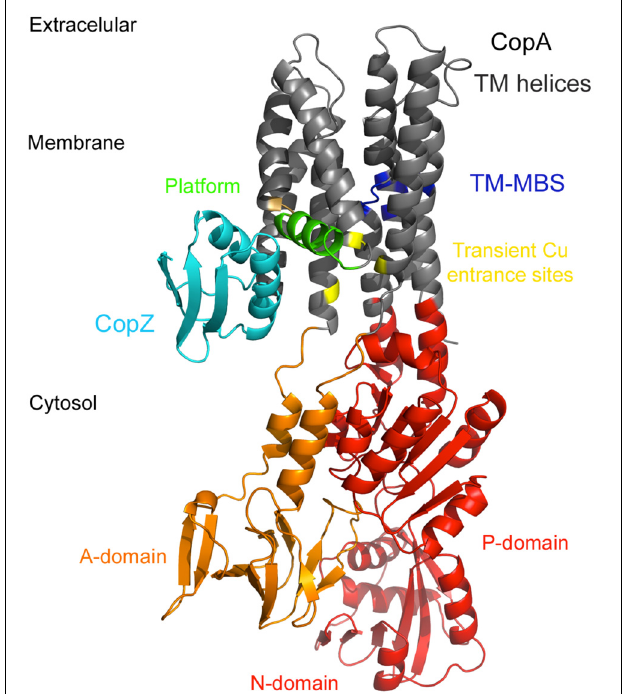
FIGURE 2 | Structures and interaction between cytosolic Cu + -chaperones and Cu + -ATPases. Archeoglobus fulgidus C-terminal Cu + binding domain of CopZ modeled using Enterococcus hirae CopZ (Protein Data Bank code 1CPZ) in light blue . A. fulgidus CopA modeled using Legionella pneumophila CopA (Protein Data Bank code 3RFU) as a template. The transmembrane segments (TM) are in gray , the electropositive platform helix is highlighted in green , the Cu + entrance site aminoacids are in yellow , the transmembrane metal binding sites (TM-MBS) in dark blue , the actuator (A) domain in orange , the nucleotide (N) binding and (P) phosphorylation domain in